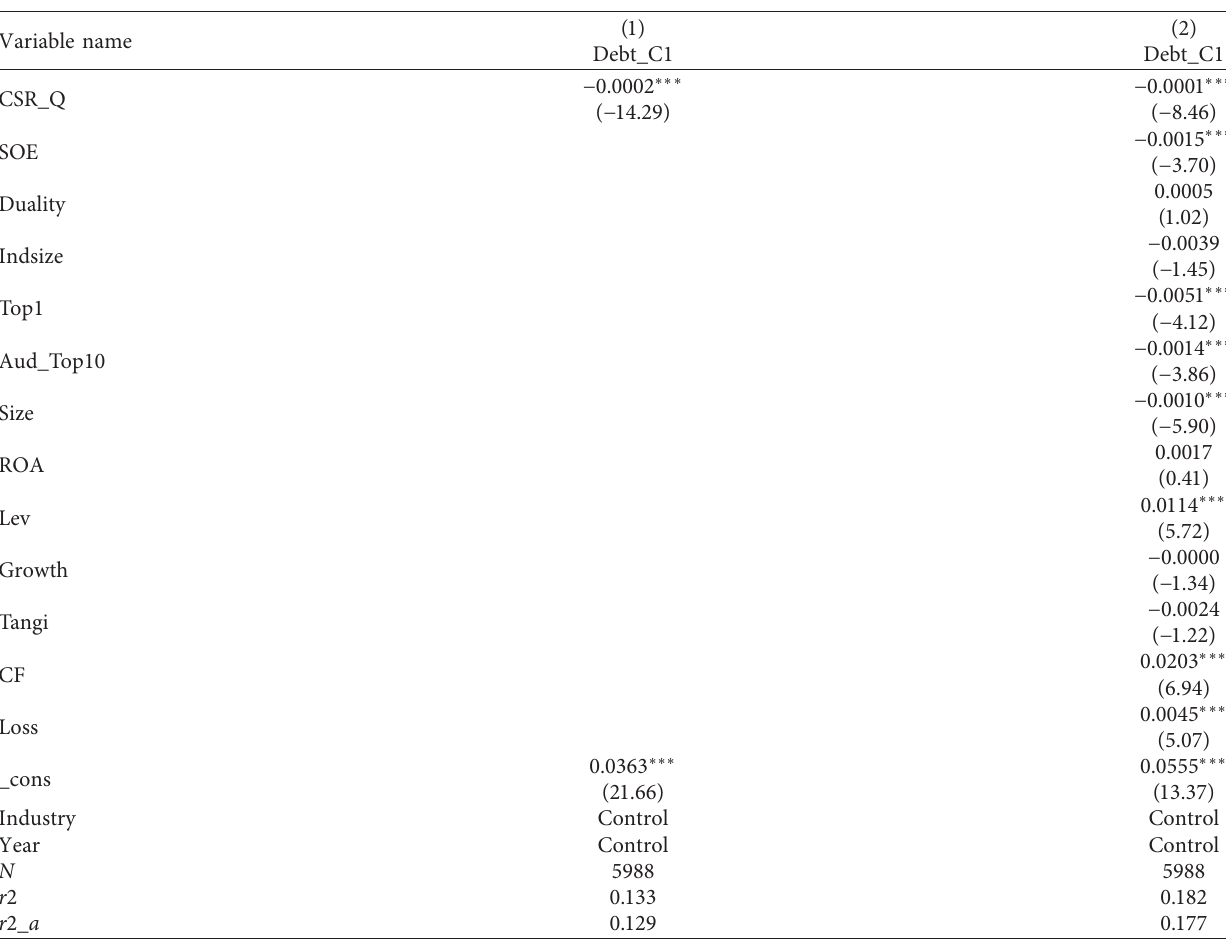
Table 8: Robustness test 1: replacement of the debt financing cost measure.